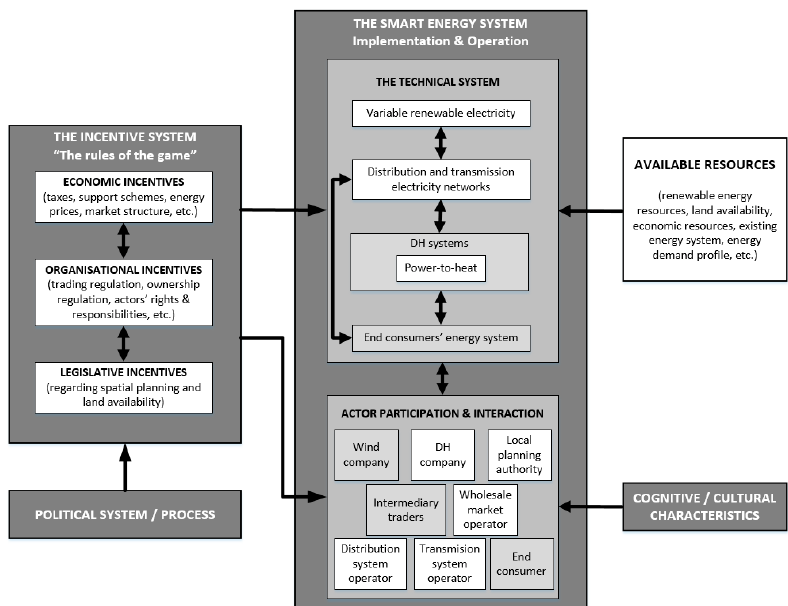
Figure 1. The theoretical approach of the study, inspired by [12] and [11]. The white boxes in the diagram present the elements of SESs included in the scope of the study. The interactions between the actors are not drawn because questioning and analysing those interactions is one of the objectives of the study. DH: district heating.